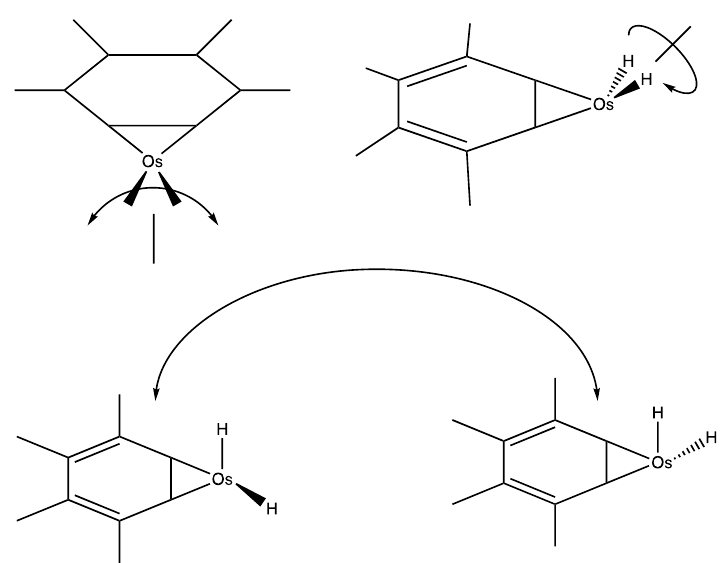
Figure 7. Interconversion of B3 ortho ( lower left ) and B3’ ortho ( lower right ). Two views of the TS appear at top . Table 2. Energetics ( B97XD/def2-tzvp) for landmarks along the C path for H transfer to polycyclic Os species from the most stable C species of OsC 6 H 6 cation. Species labels and Gibbs energies (G) in Hartrees are reported along with relative Gibbs energies in electron volts (eV). The energy reference point is the energy of the C 6v complex of the Os cation with benzene, OsC 6 H 6 + (see Table 1).